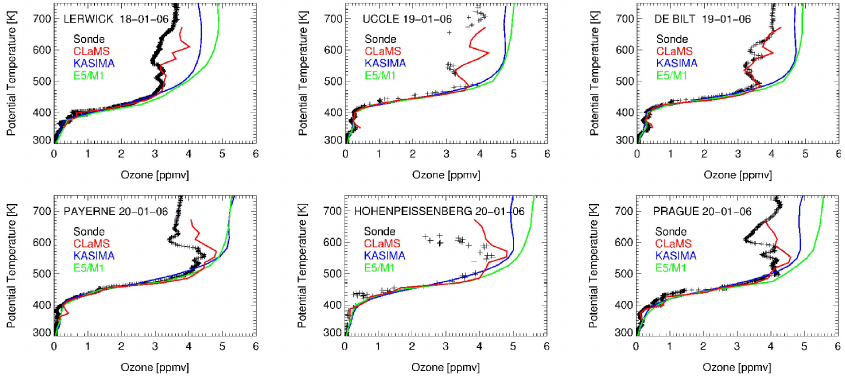
Fig. 11. Measured and simulated ozone profiles for the six ozone sounding stations, for the days when minimum total ozone was observed; ozone sonde data given by black crosses, CLaMS results by red, KASIMA results by blue, and E5/M1 results by green lines,